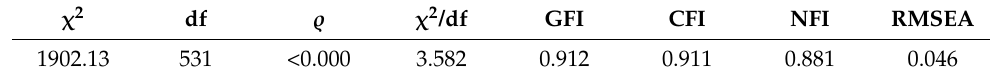
Table 3. Fit indices for the CFA of variables.